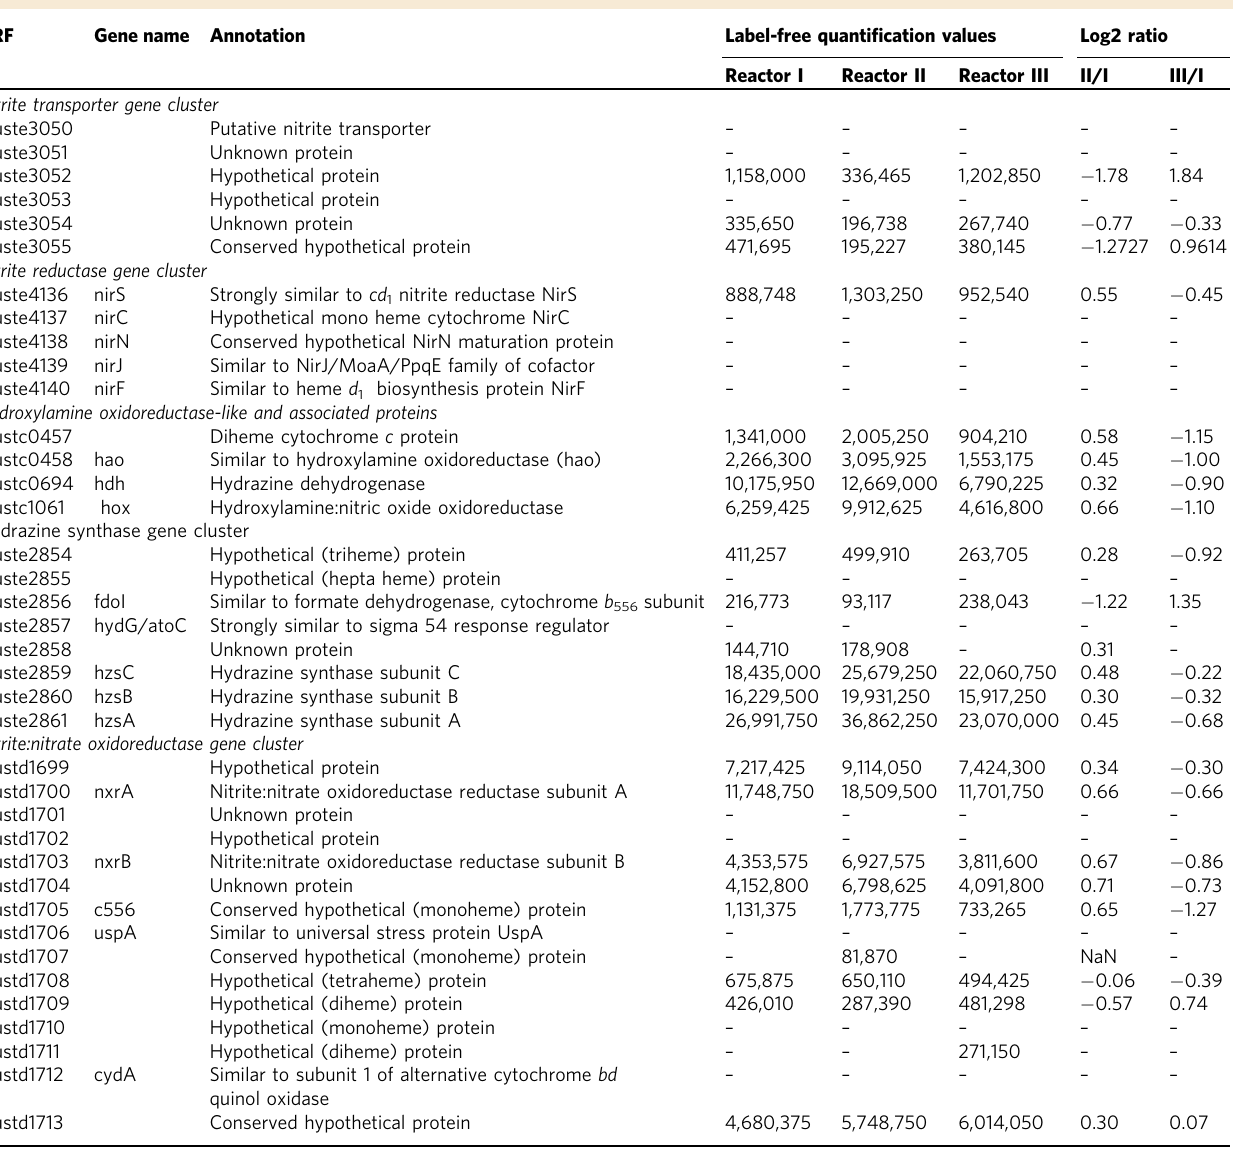
Table 2 Detection of proteins involved in nitrite and NO